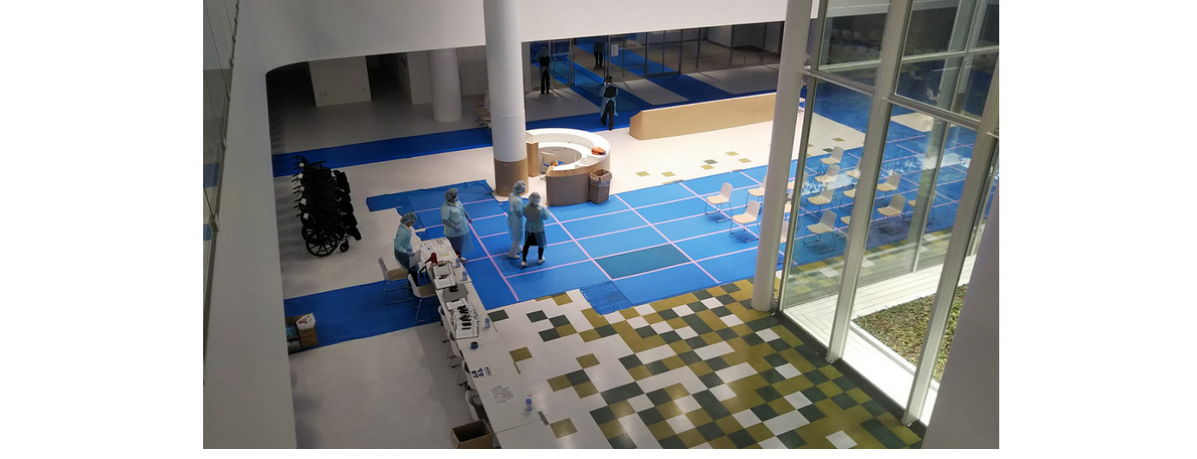
Figure 5. At the entrance of the quarantine building. Body temperature and SpO2 were checked while people were registered and baggage was picked